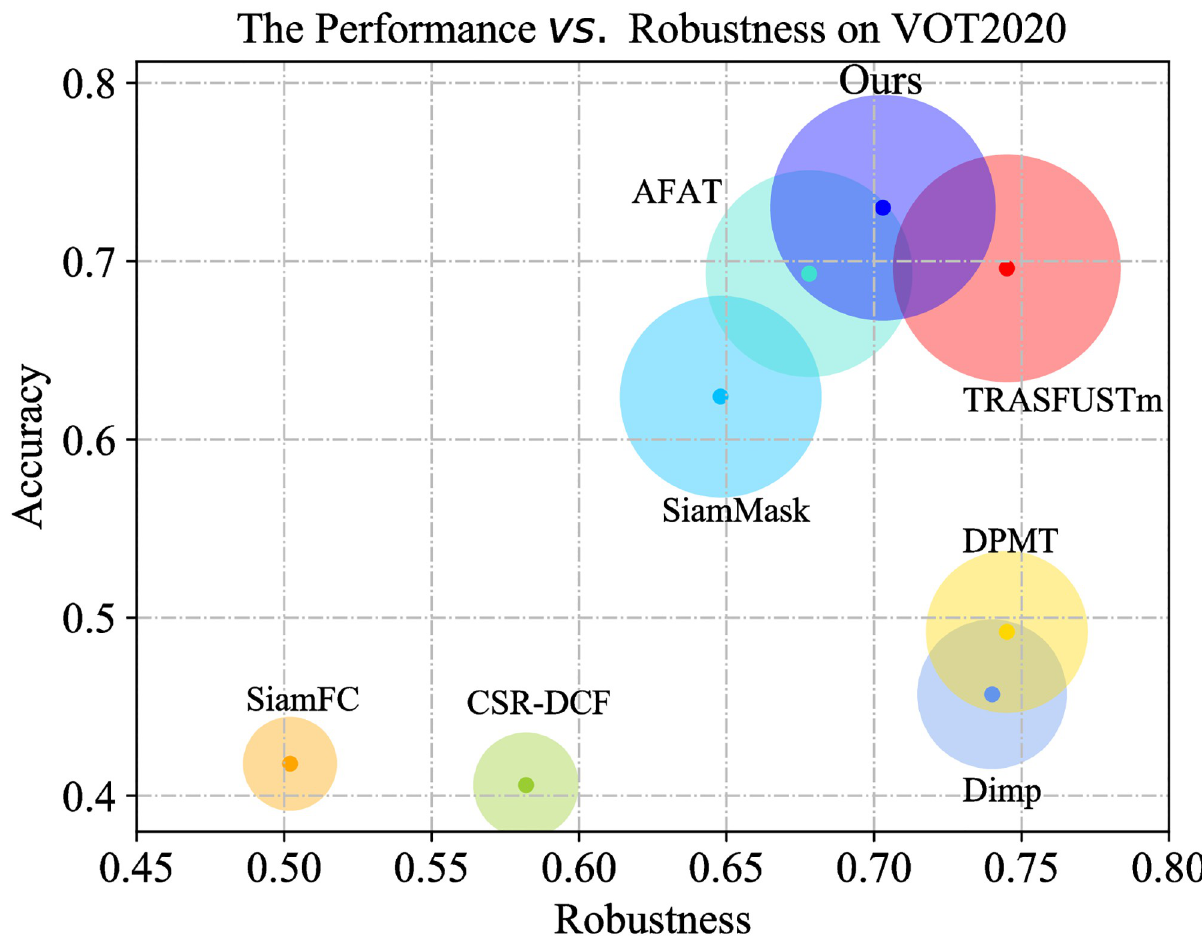
Fig 6. Comparison with state-of-the-arts on VOT-ST2020. We equip ASCF with a refinement module proposed by AlphaRef [62] to generate segmentation masks.